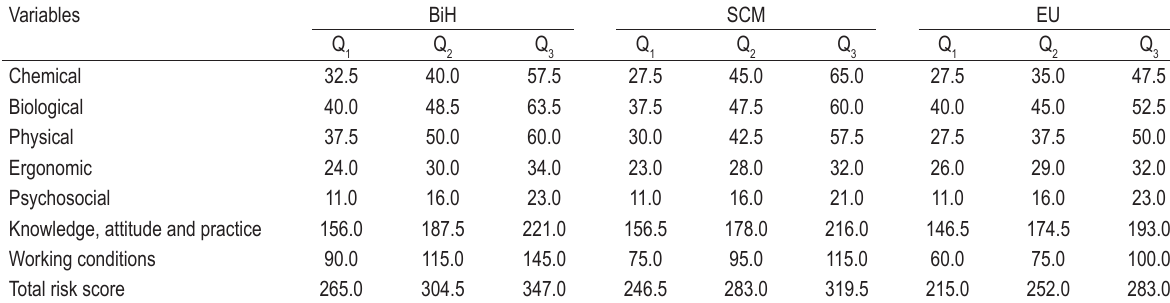
TABLE 2. Percentile of hazard groups and risk score